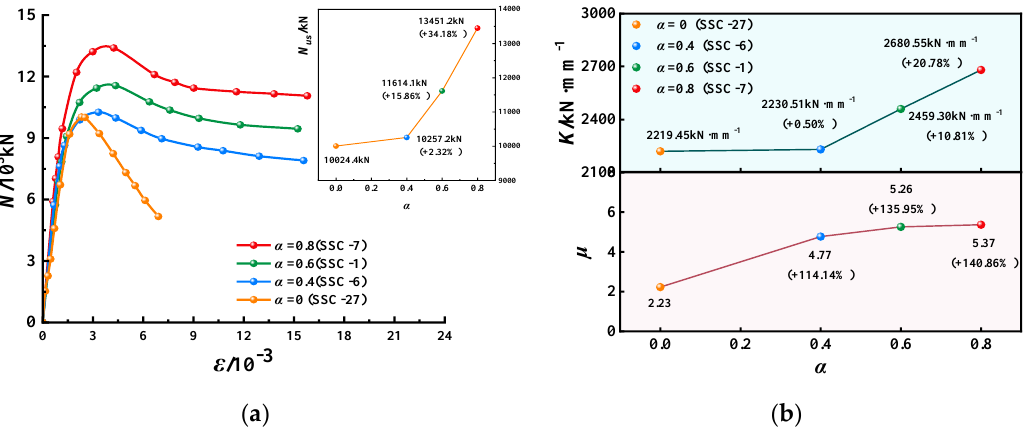
Figure 17. N - ε curves, K and µ of EGCSSCs with different α : ( a ) N - ε curves of specimens with cross-section height of 800 mm. ( b ) K and µ of specimens with cross-section height of 800 mm.